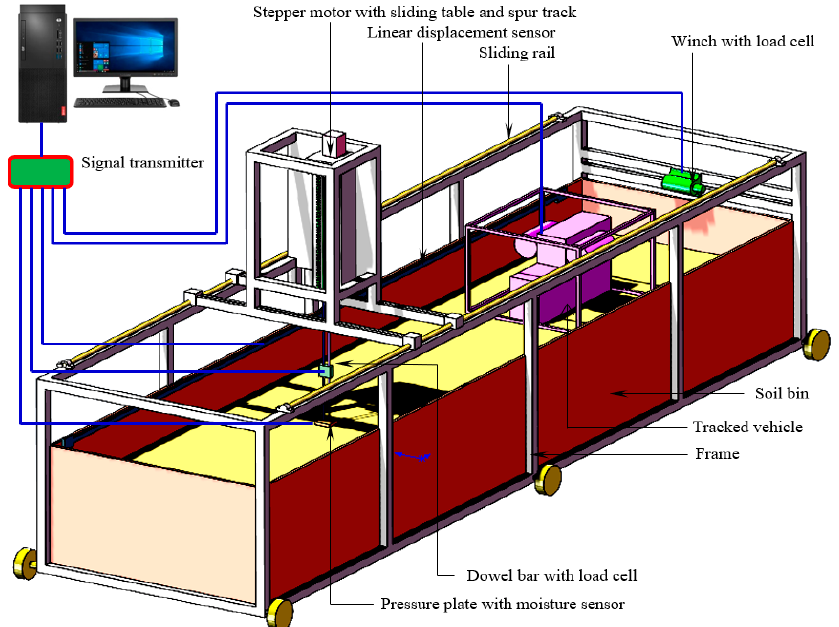
Figure 5. Overall structures and key components of the experimental platform.